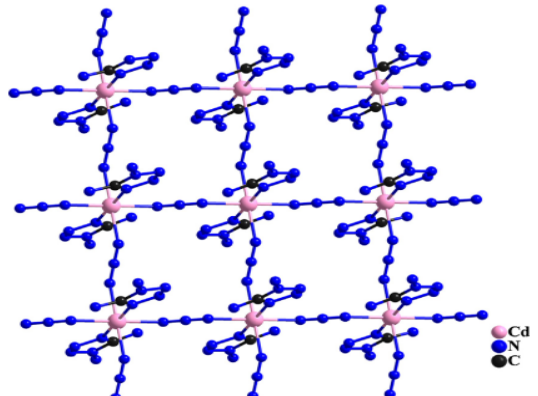
Figure 2. The two zigzag chains linked by azido ligands are vertical to each other, and a novel 2D rectangulargrid-like layer parallel to the ab -plane of unit cell is formed [37].